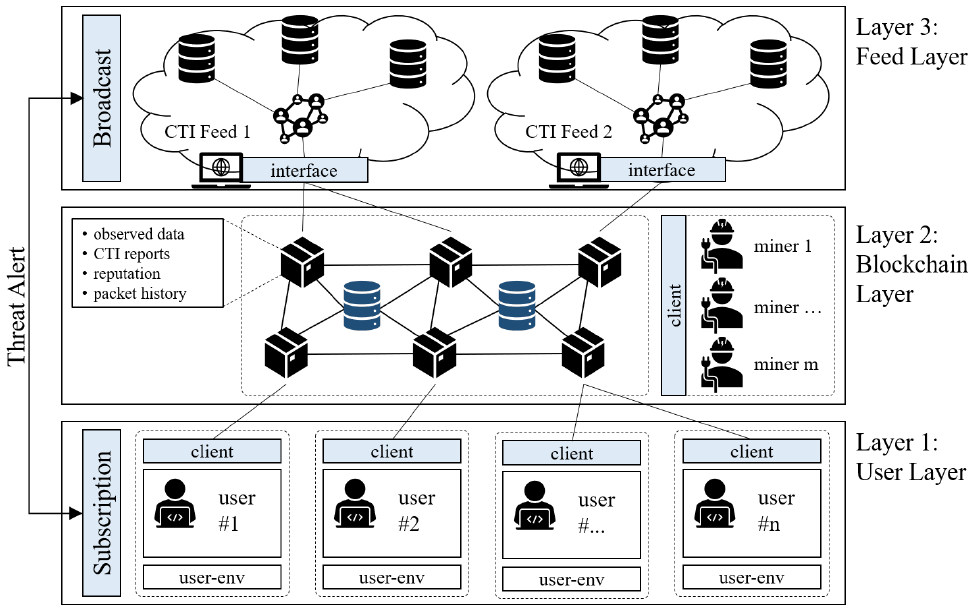
Figure 4. Architecture of the blockchain-based open cyber threat intelligence system